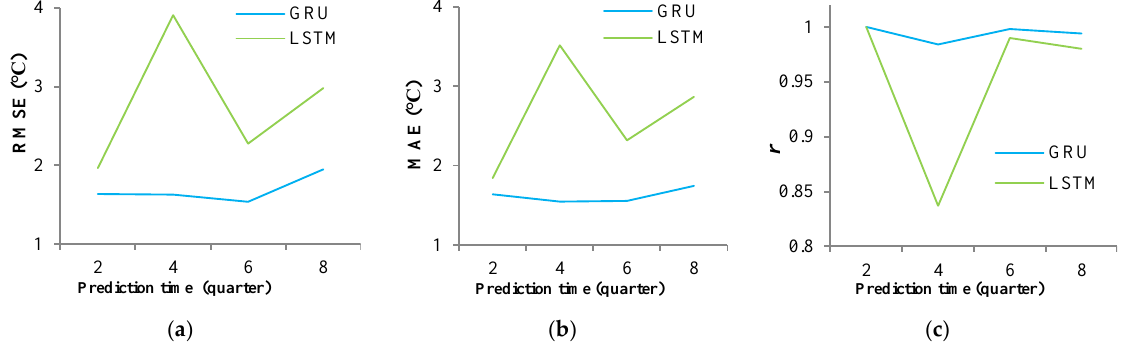
Figure 13. Prediction accuracy for different time lengths for the P2 site. ( a ) RMSE with different prediction lengths; ( b ) MAE with different prediction lengths; ( c ) r with different prediction lengths.